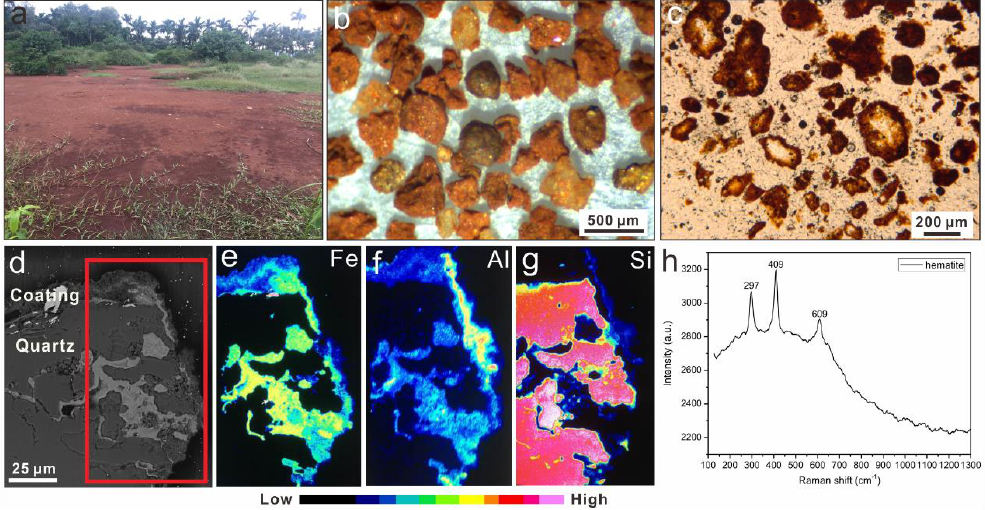
Figure 1. Field occurrence ( a ), hand specimen ( b ), optical image ( c ), back-scattered image ( d ), elemental distribution patterns ( e – g ) and Raman spectrum ( h ) of soil Fe coatings. The rectangle in panel ( d ) indicates the EDS mapping region.